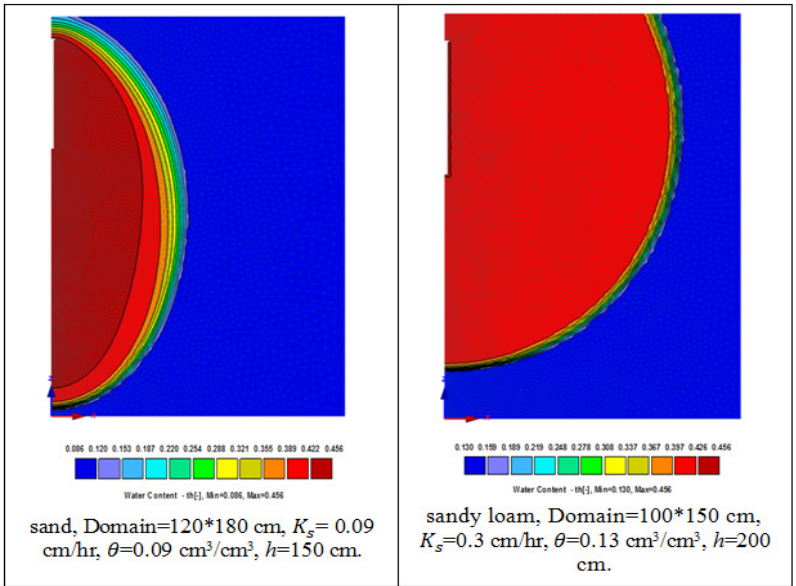
Fig. 2. Simulation of wetting patterns from a ceramic pipe in sand and sandy loam soils with pipe length of 50 cm, and after 1.5 hr operating